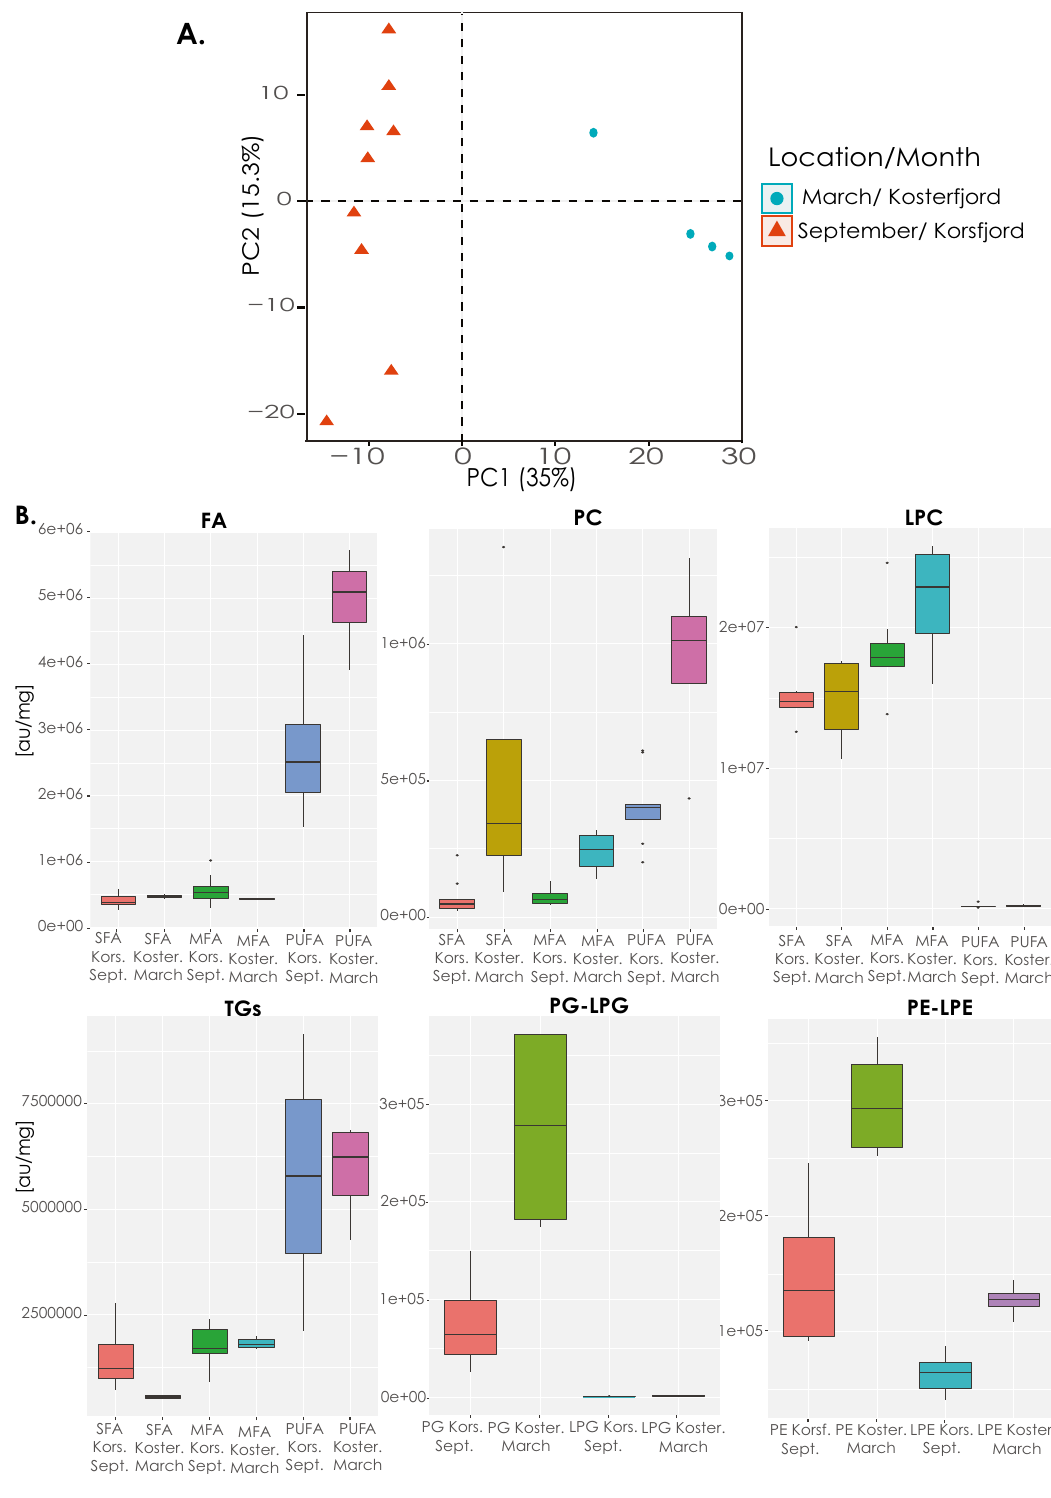
Figure 4. Lipid signal of different lipid categories in different locations/months. ( A ) Principal Component Analysis (PCA) indicating the scores of the first two principal components of the lipidome in the sponge individuals between the two different locations. ( B ) Boxplots depicting the average signal [au/mg] extracted from all the lipids of each lipid category in the two different sampling locations/months. Fluctuations in signal [au/mg] were calculated separately for saturated (SFA), mono-unsaturated (MFA), and poly-unsaturated (PUFA) lipids within each lipid category. Abbreviations: free fatty acids (FFA), phosphatidylcholines (PC), lyso-phosphatidylcholines (LPC), triacylglycerides (TGs), phosphatidylglycerols (PG), lyso-phosphatidylglycerols (LPG), phosphatidylethanolamines (PE), lyso- phosphatidylethanolamines (LPE), saturated (SFA), mono-unsaturated (MFA), poly-unsaturated